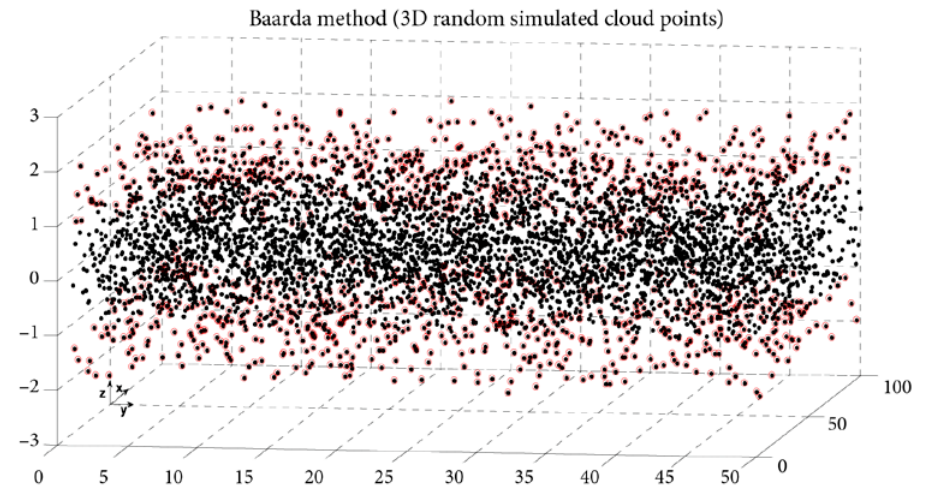
Fig. 4. Outliers detection based on Baarda method applied into the randomly simulated 3D point clouds ( x, y and z